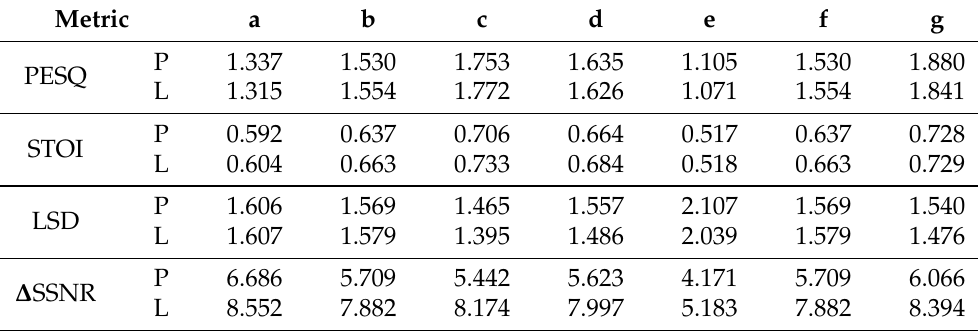
Table 9. Average results for PESQ, STOI, LSD, and ∆ SSNR when testing the seven DNNs using plain (P) and Lombard effect simulated speech (L) at six SNR levels, from − 5 to 20 with a step of 5.